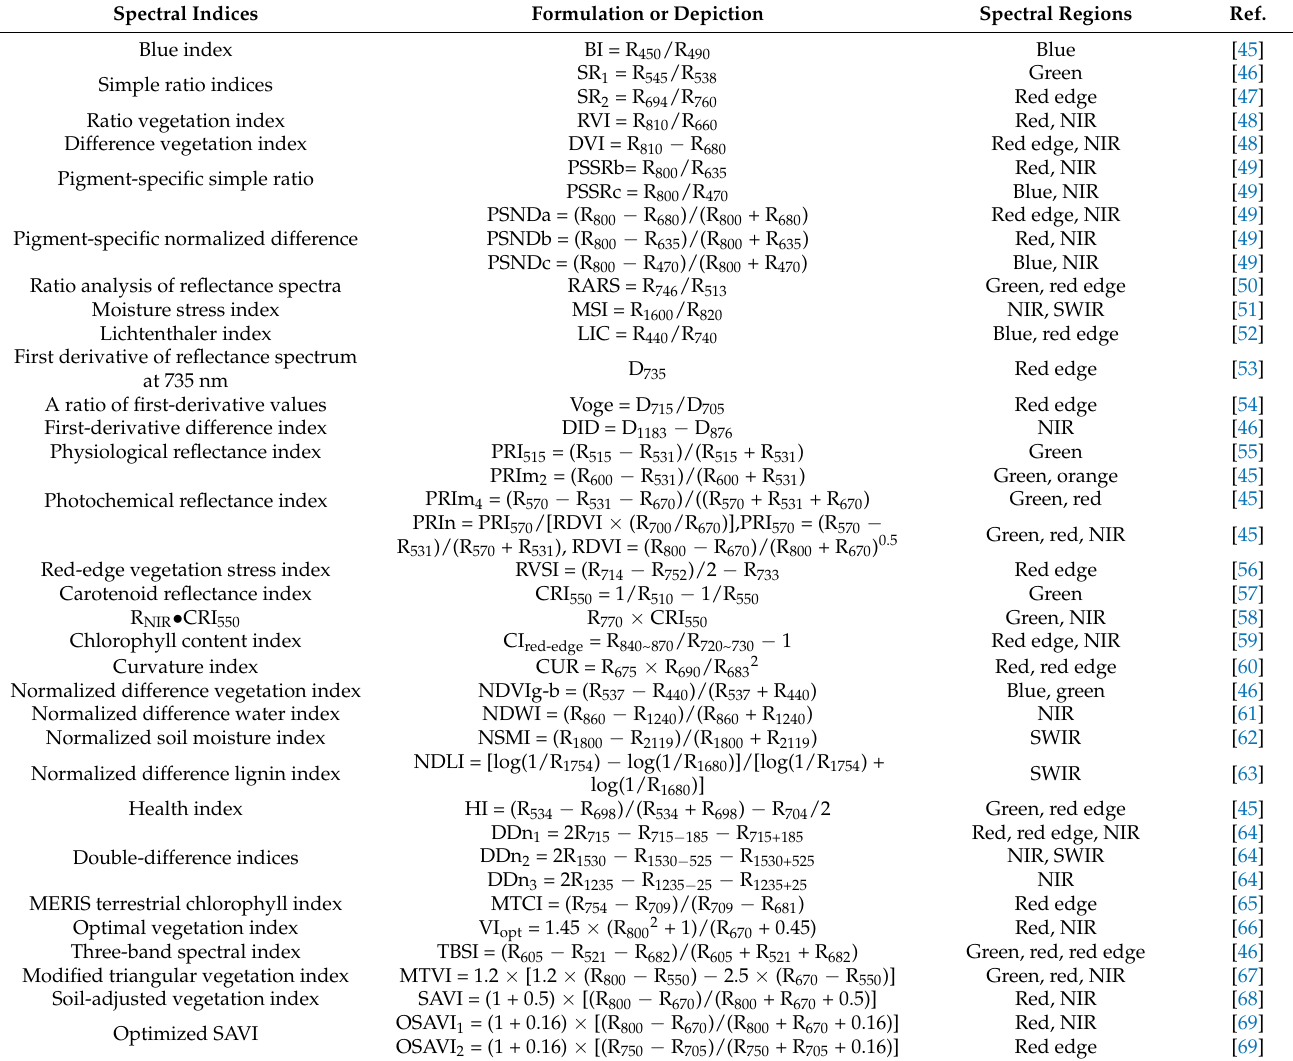
Table 1. Selection of SVIs as input variables of